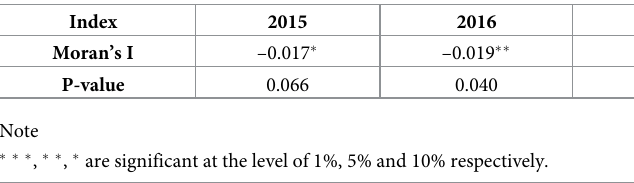
Table 5. Test results of spatial correlation of intelligent manufacturing